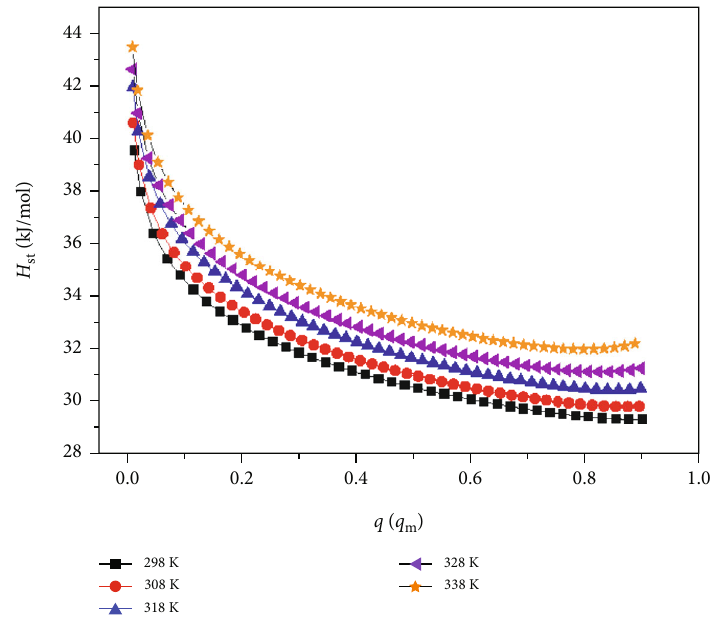
Figure 9: The isosteric heat of adsorption ( H